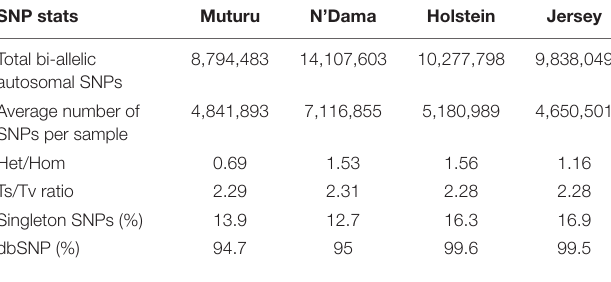
TABLE 1 | Summary statistics of the SNPs in the four Bos taurus cattle.